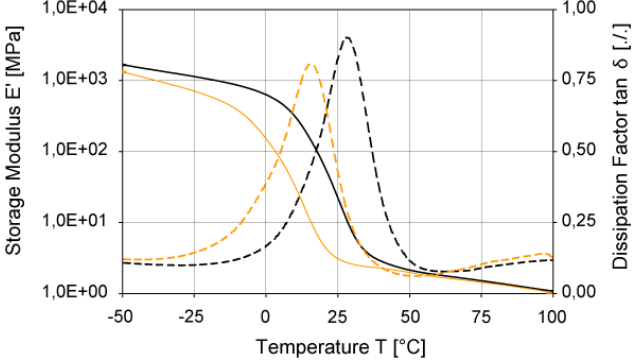
Figure 1: DMA thermogram for two different PVB-foils